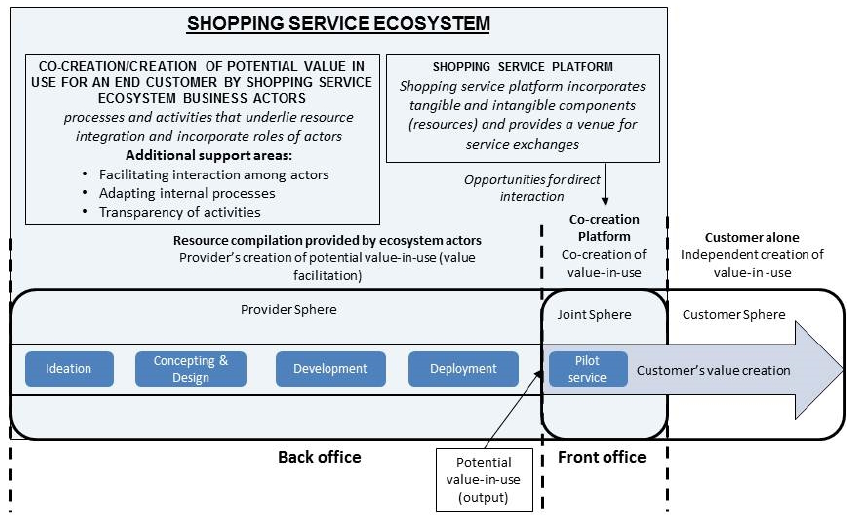
Fig. 4. Shopping service elements of the pilot case mapped with the extended value generation process framework. Source: Adaptation of Grönroos and Gummerus (2014, p. 218) and